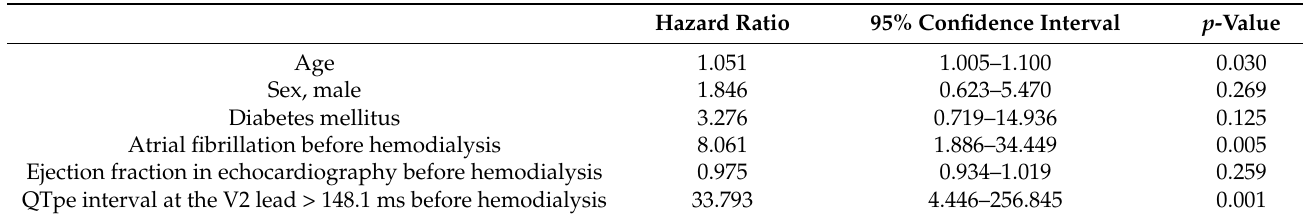
Table 5. Cox analysis of the risk of sudden cardiac death predicted by ECG